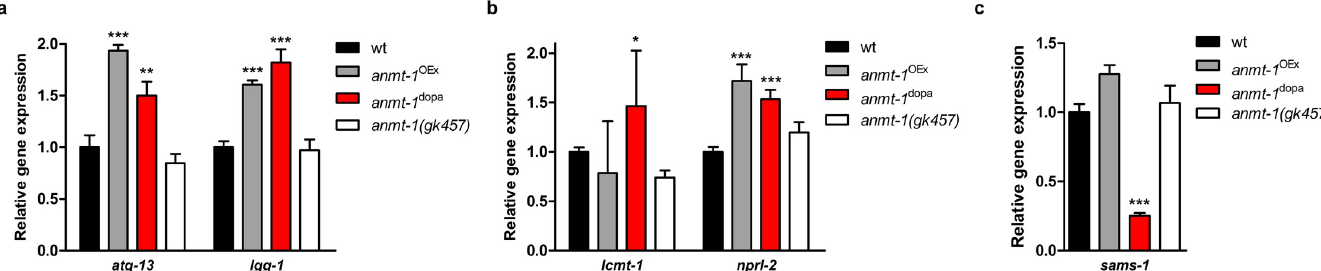
Fig 6. anmt-1 regulates sams-1 and autophagy gene expression. a–c Relative gene expression in a mixed population of wt (black), anmt-1 OEx (grey), anmt-1 dopa (red) and anmt-1(gk457) (white) of a atg-13 and lgg-1 , b lcmt-1 and nprl-2 , and c sams-1 . � : p < 0.05, �� : p < 0.01, ��� : p < 0.001.